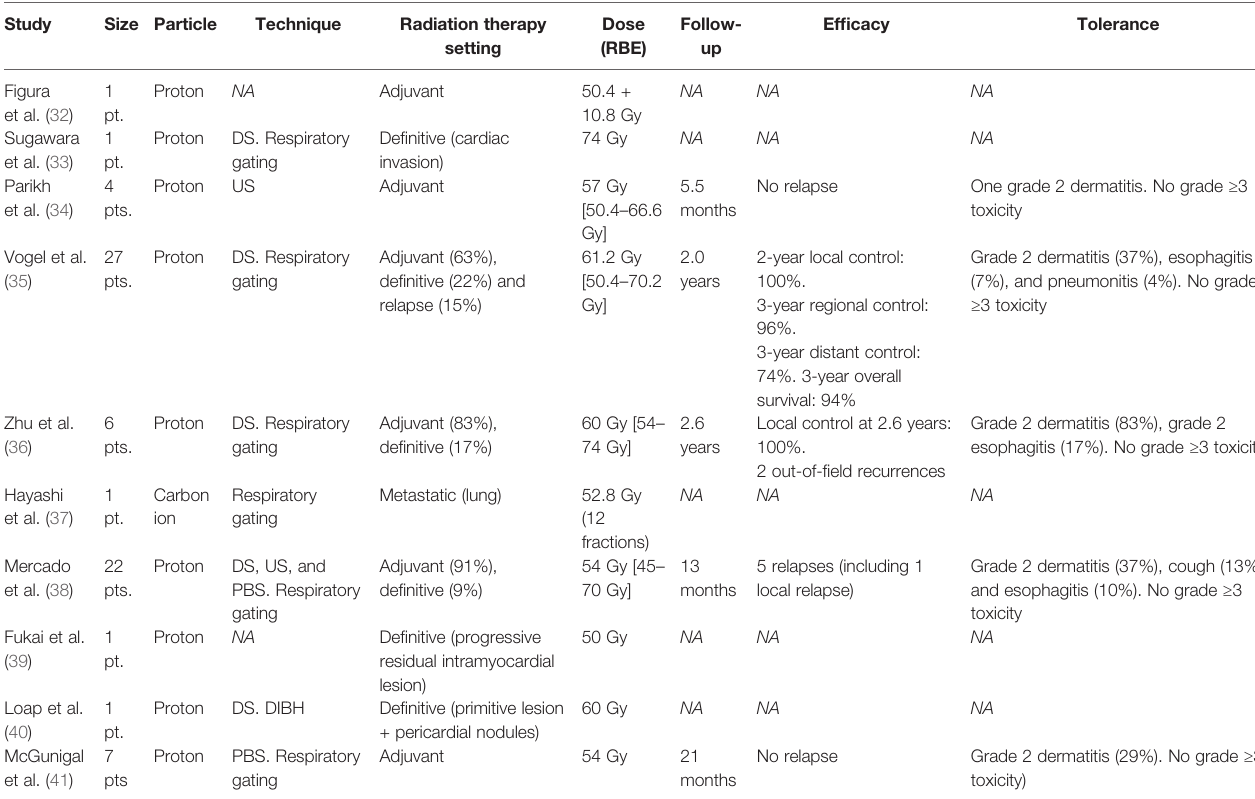
TABLE 1 | Current experience on hadrontherapy for thymic epithelial